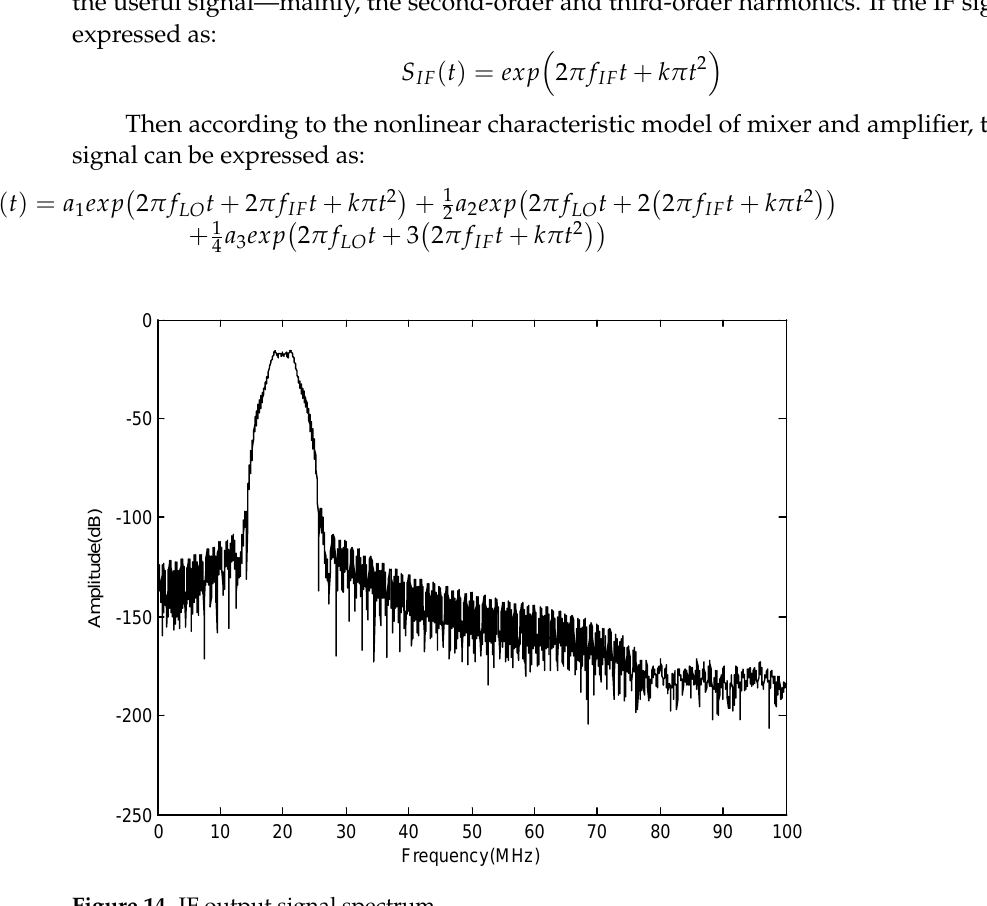
Figure 14. IF output signal spectrum.